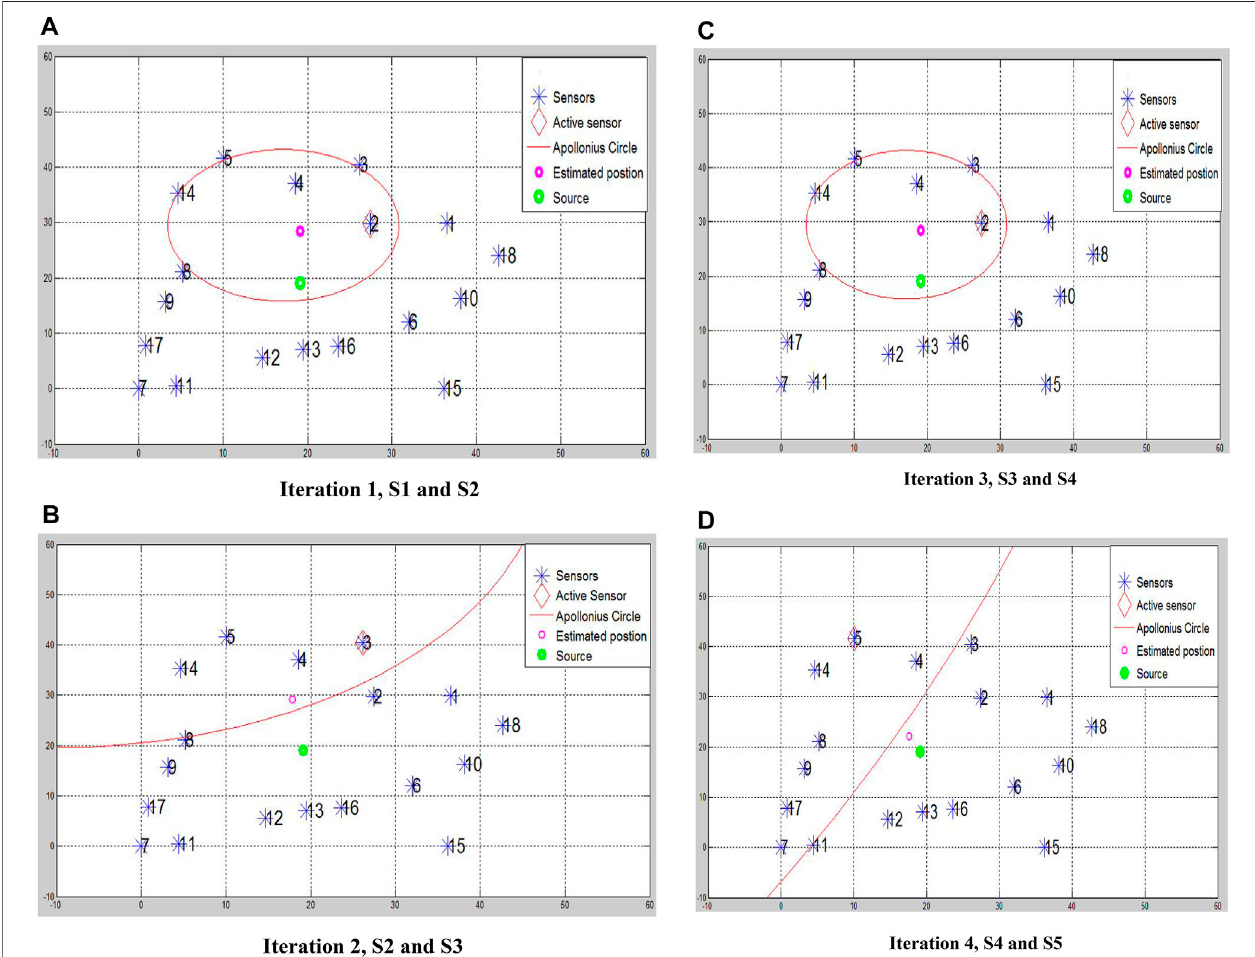
FIGURE 3 | The fl ow of the Algorithm. (A) Iteration 1, S1 and S2 (B) Iteration 2, S2 and S3 (C) Iteration 3, S3 and S4 (D) Iteration 4, S4 and S5.